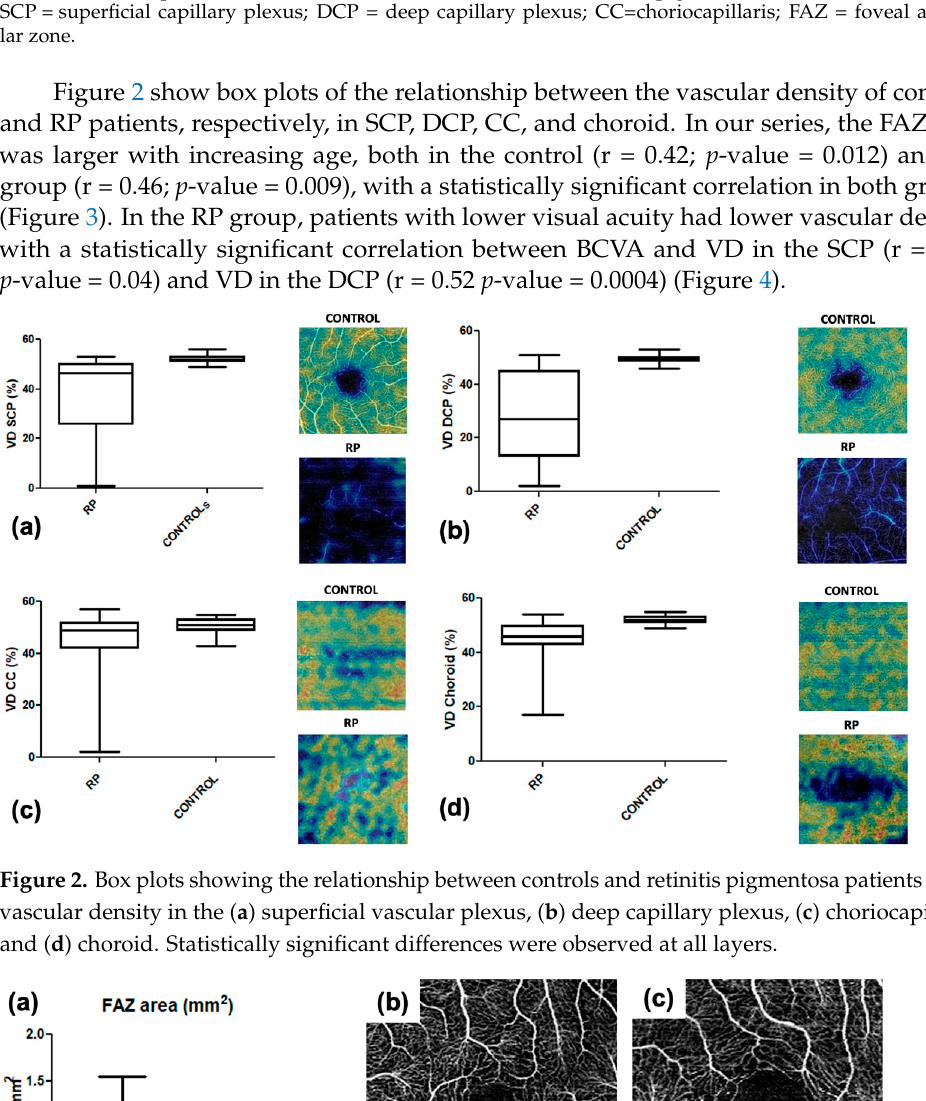
Figure 4. Scatterplots showing the relationship between vascular density in superficial capillary plexus ( a ) and deep capillary plexus ( b ) and best ‐ corrected visual acuity (BCVA), expressed in Log ‐ MAR, in retinitis pigmentosa patients. In RP patients, we also found a statistically significant correlation between subfoveal choroidal thickness and VD in the SCP (r = 0.43, p ‐ value < 0.001) and in the DCP (r = 0.35, p ‐ value < 0.001). 4. Discussion Several studies recently conducted on patients affected by RP with OCTA have re ‐ ported a reduction of the retinal and choroidal blood flow, when compared to controls, and an increase in size of the foveal avascular zone (FAZ) [7–9,12]. Ling et al. [13] con ‐ ducted a meta ‐ analysis of the relevant published studies on OCTA in RP patients, show ‐ ing that both retinal and choroidal vessels were attenuated in RP patients when compared with controls. Additionally, they revealed that the FAZ was larger and foveal thickness was smaller in RP patients compared with controls, suggesting that these microvascular parameters may have significant value in the diagnosis and monitoring of disease pro ‐ gression. Jauregui et al. [15] examined the OCTA progression over time and found that perfusion density decreased significantly at the superficial and deep capillary plexus and FAZ area increased significantly at the superficial and deep layers. The reduction of retinal blood flow appeared to be significantly correlated to visual function in RP patients [6,11]. A recent study conducted by means of widefield swept source OCTA showed an impairment of retinal and choroidal perfusion density and ves ‐ sel length density in both the central and peripheral retina of RP patients, if compared to